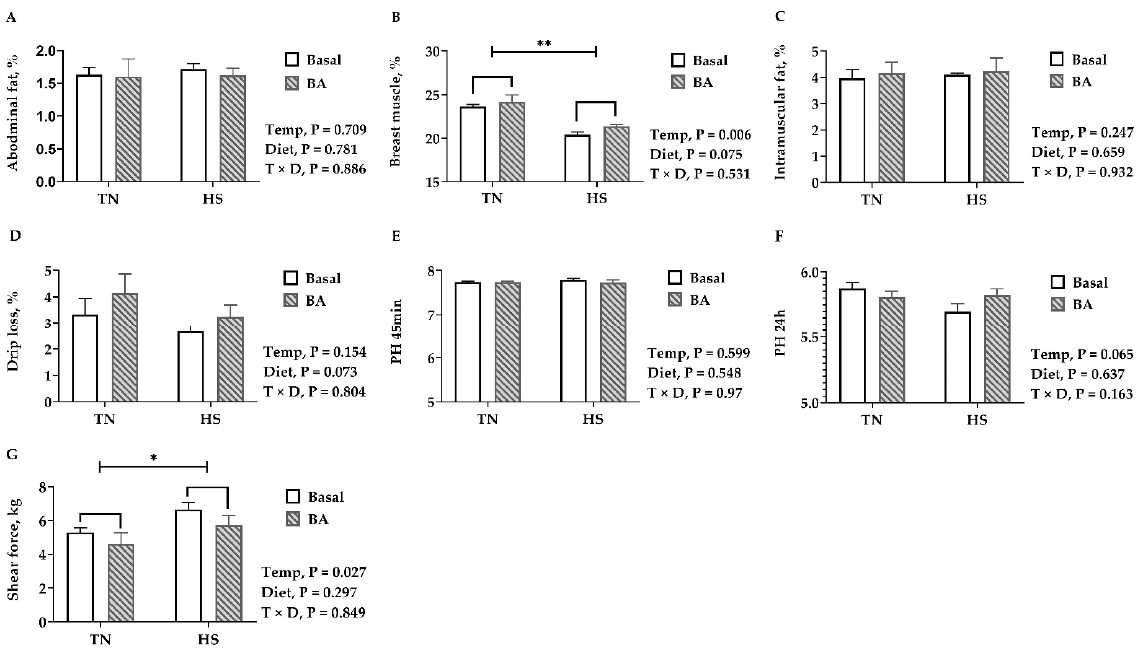
Figure 2. Carcass and meat quality of broilers fed with 0 or 200 mg/kg bile acids under thermoneutral (TN) and heat-stressed (HS) conditions. ( A ) Abdominal fat rate; ( B ) breast muscle rate; ( C ) intramuscular fat (freeze-dried samples); ( D ) drip Loss; ( E ) pH at 45 min postmortem; ( F ) pH 24 h postmortem; ( G ) shear force. Data are presented as the mean ± SEM (n = 6 for each mean). Different letters indicate significant differences * p < 0.05 and ** p <